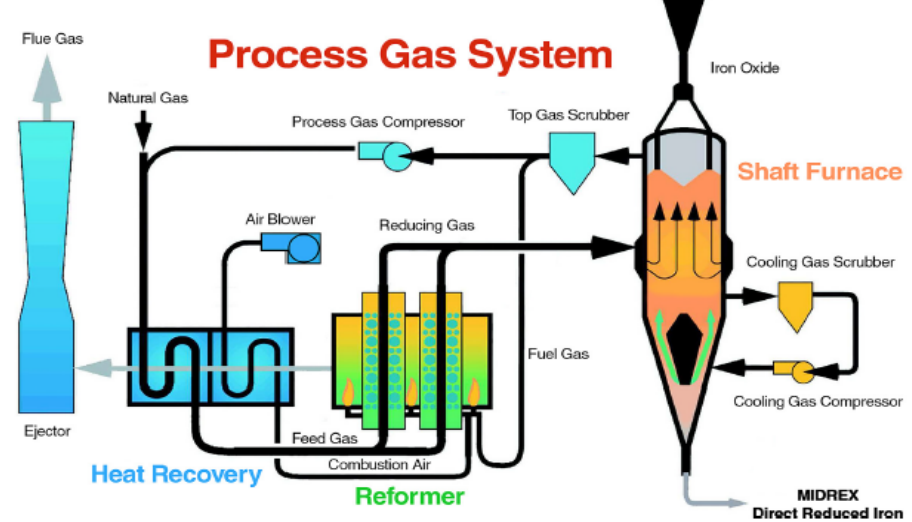
Figure 1. Flowsheet of MIDREX process [15].